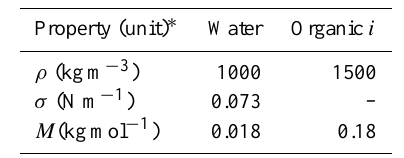
Table 3. Properties of water and organic compounds used in Köhler curve calculations (see Eq.